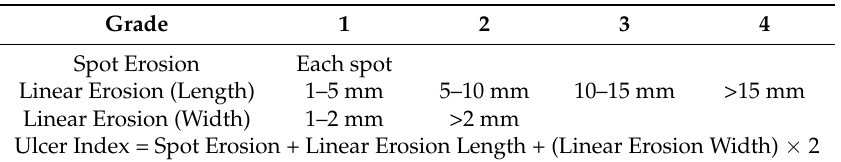
Table 1. Scoring criteria for ulcer index.